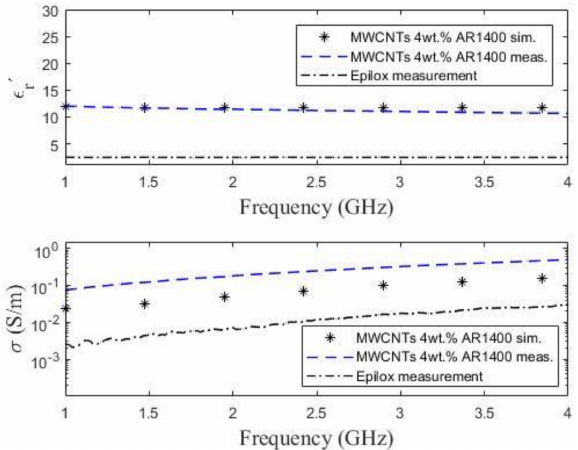
Figure 7. Real part of permittivity (top) and conductivity (bottom) versus frequency for 4wt% MWCNT-loaded epoxy resin: experimental measurements (dashed line) and simulations (stars); Pure epoxy (Epilox) resin (dash-dotted